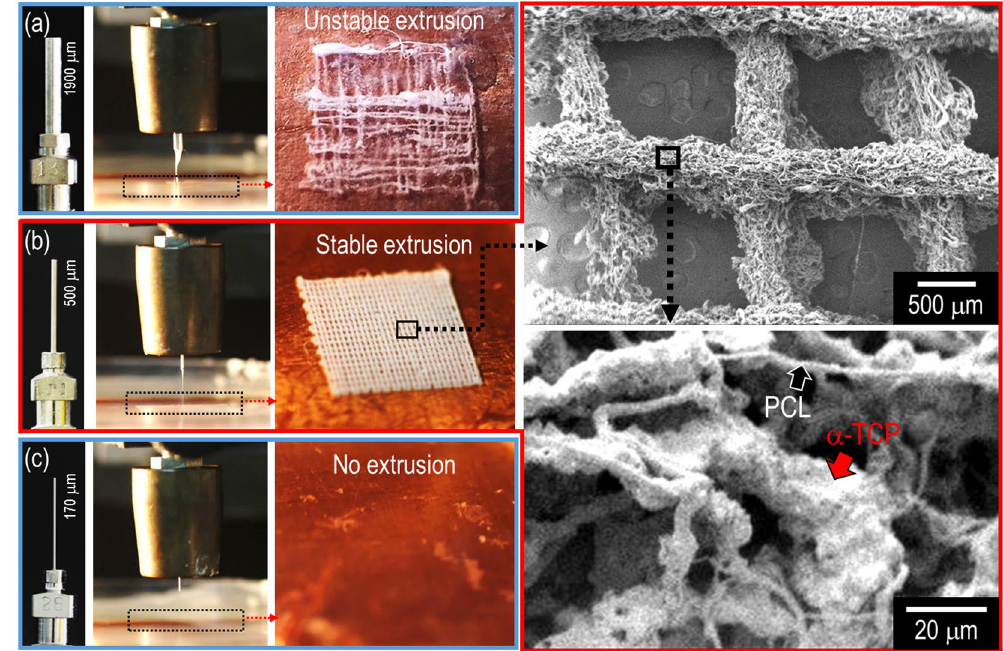
Figure 3. Effect of nozzle diameters (( a ) 1.9 mm, ( b ) 0.5 mm, and ( c ) 0.17 mm) on the flow stability and the formation of layer-by-layered mesh structure. In the SEM image, stably deposited struts consisting of entangled microfibers of the mixture (ceramic/PCL) are described. The PCL corresponds to a fibrous form, and the ceramic corresponds to an agglomerated shape that is attached on the PCL